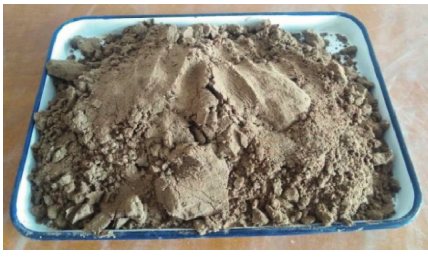
Figure 1: Saline soil used in